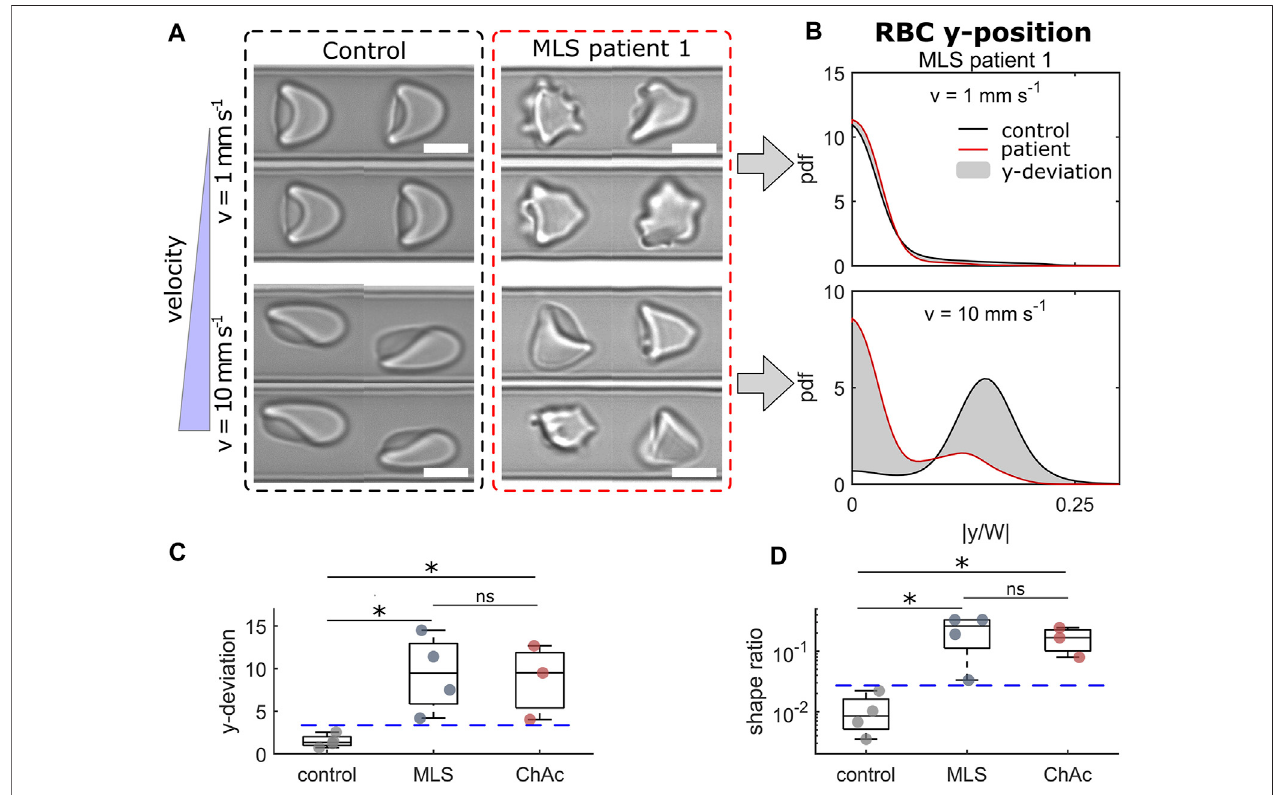
FIGURE 2 | Results of RBCs from neuroacanthocytosis syndrome (NAS) patients. (A) Representative RBC shapes for a healthy control (left) and an MLS patient (right) at low (top) and high velocity (bottom). Scale bars represent 5 µm. (B) Probability density functions (pdfs) of the cell ’ s y-position distribution for the control and an MLS patient atthevelocitiesshown in (A) .Thegray areaindicatesthedifferencebetweenboth distributions. (C) Deviationbetweenthey-positiondistributions basedon the average distribution for healthy controls in the entire velocity range of 1 – 10 mm/s. (D) Shape ratio between non-normal RBCs (acanthocytes and other pathological shapes) and normocytes. * refers to a signi fi cance level of p < 0.05 and ns stands for not signi fi cant. Blue dashed horizontal lines represent thresholds between controls and NAS patients. The analysis presented was performed on an average of 4519 cells per patient/donor (between 2422 and 5484